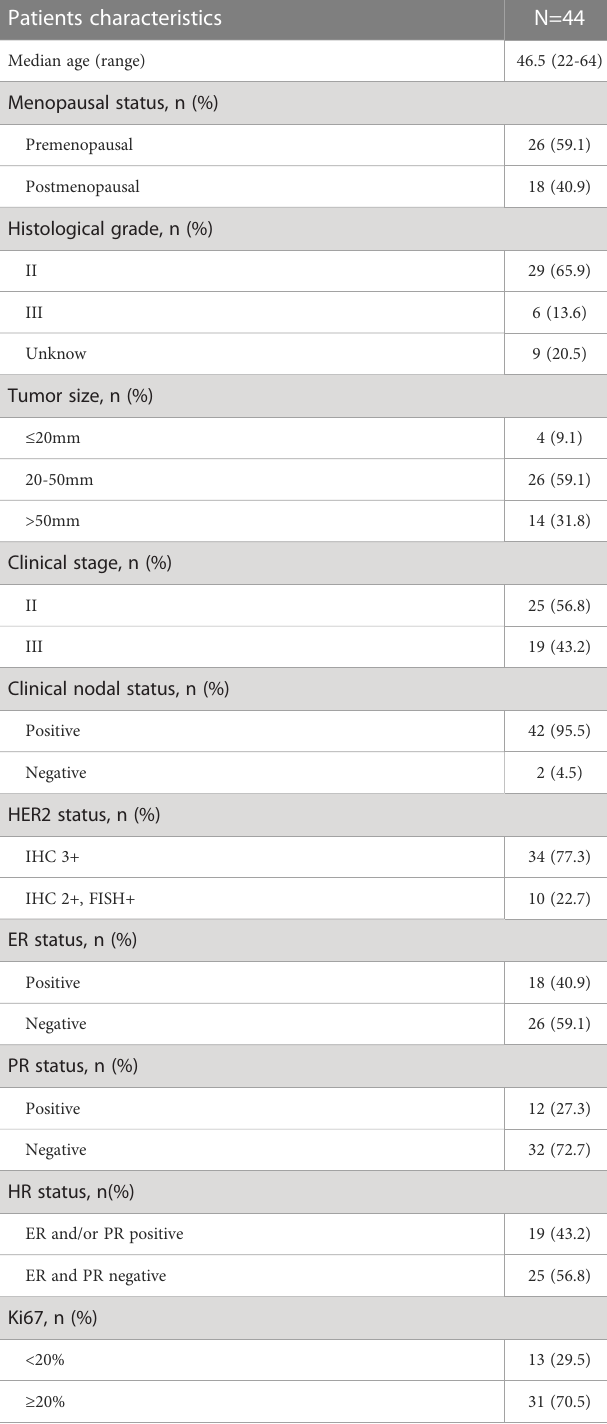
TABLE 1 Patients characteristics at